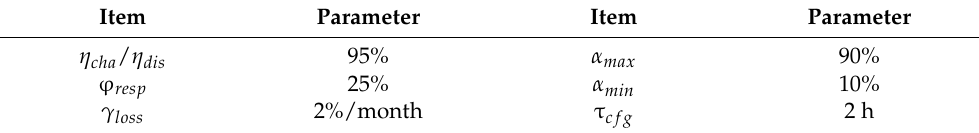
Table 3. Parameters of load-side EES